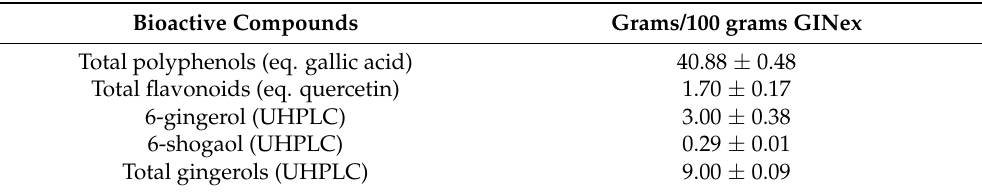
Table 2. The content of total polyphenols, flavonoids, 6-gingerol and 6-shogaol in freeze-dried GINex (grams/100 grams GINex).